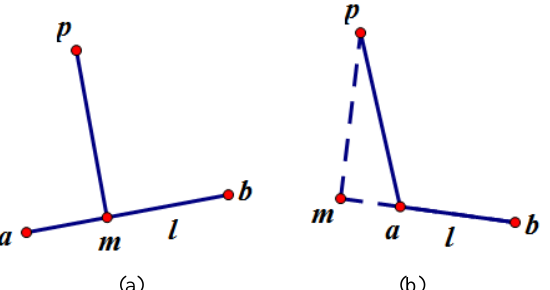
Fig1. Distance from point to line segment in two cases. (a) The pedal is on the segment. (b) The pedal is not on the segment.